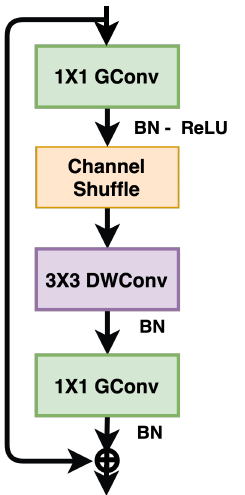
Figure 8. Fire module: the backbone module of the squeeze network.